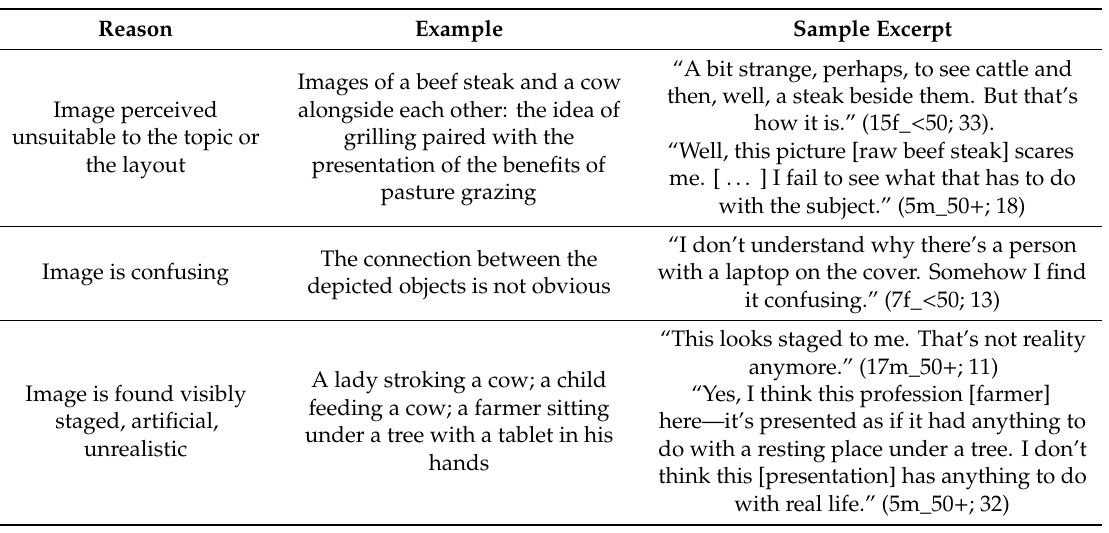
Table 2. Participants’ reasons for negative perceptions of